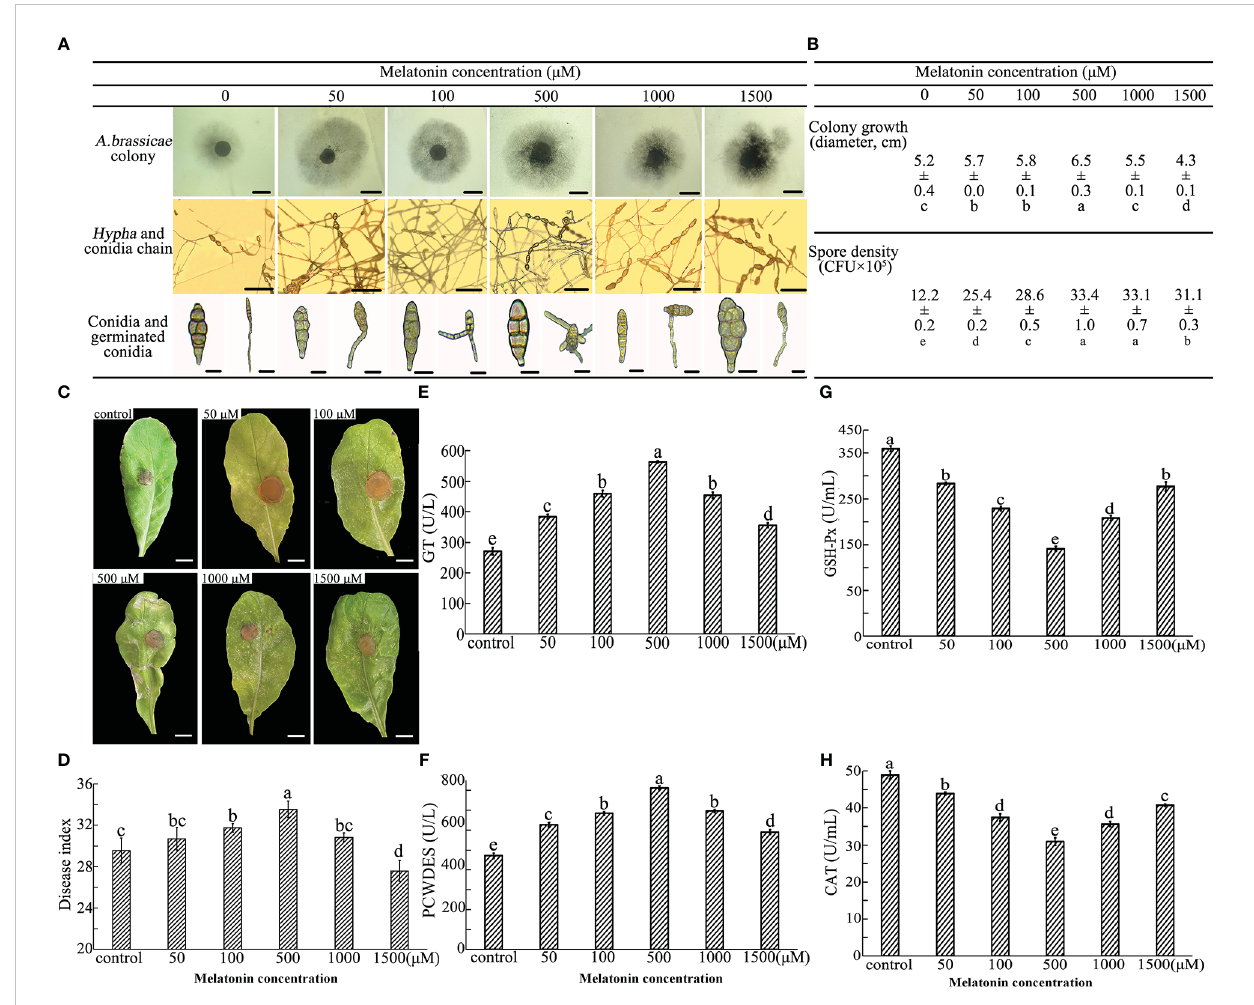
FIGURE 3 Effect of exogenous MT on A brassicae growth, development, virulence, and enzyme activities. A brassicae were applied to SNA medium supplemented with 0-1500 m M exogenous MT and incubated for 7 days for colony growth and additional 7 days under ultraviolet for conidia formation and germination. (A, B) Colony growth, conidia development and conidia germination of A brassicae , bars in 1 st , 2 nd and 3 rd lines of image A indicate 0.5 cm, 100 m m, and 10 m m respectively. (C, D) Pathology of MT-treated A brassicae ; (E-H) Activity of redox- and virulence-related enzymes. At least 3 repeats were performed; the values are means ± SE; letters indicate signi fi cant differences; statistical analysis was performed by one-way ANOVA, p <